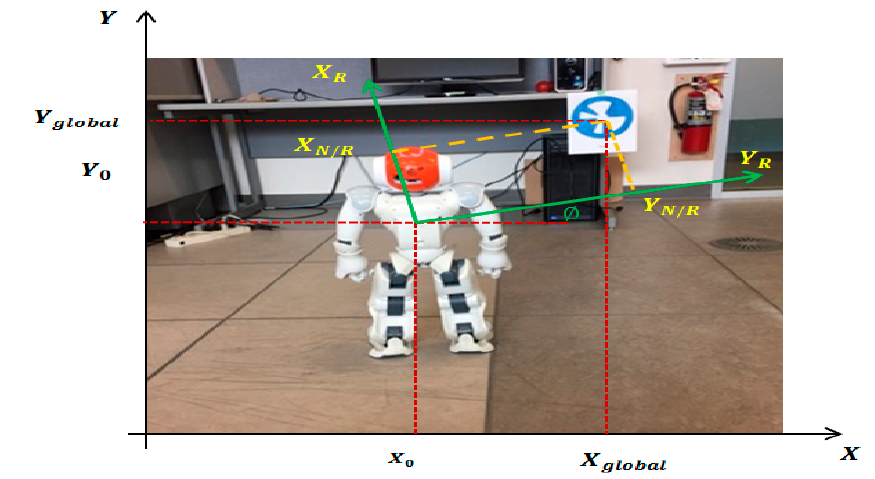
Figure 12. NAO mark global coordinates.